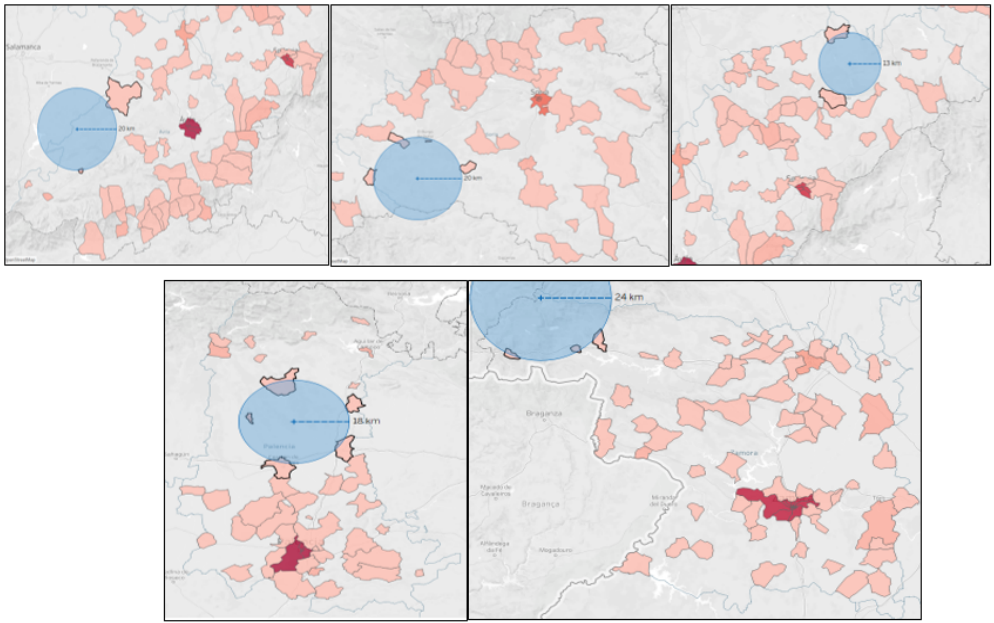
Figure 2. Distance (km) needed to obtain cash from the furthest point in each province (current situation). Source: Own elaboration based on Tableau Desktop profesional Edition .